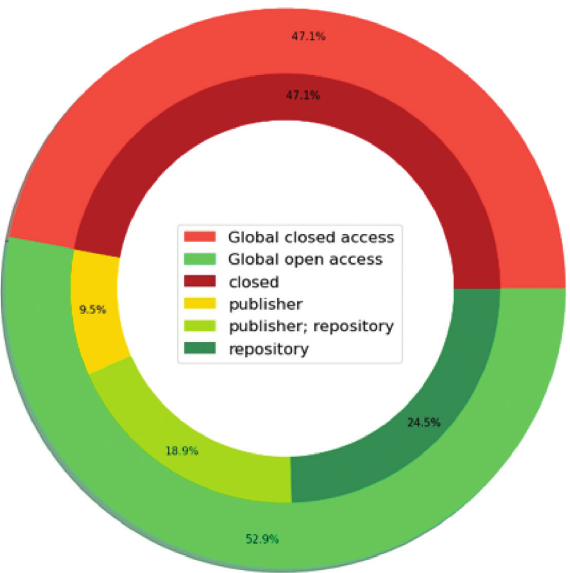
Fig. 1: Proportion of open access publications in